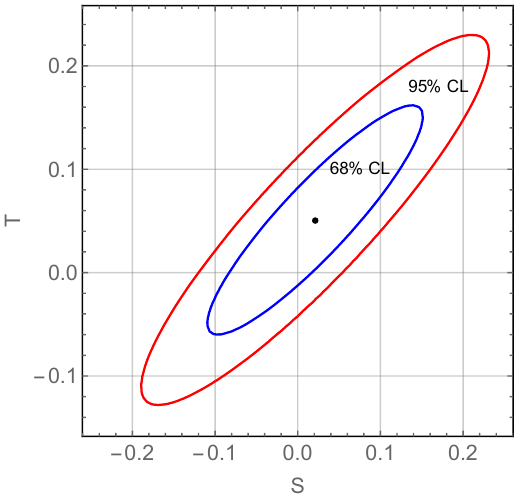
Figure 7 . The constraint on the S,T